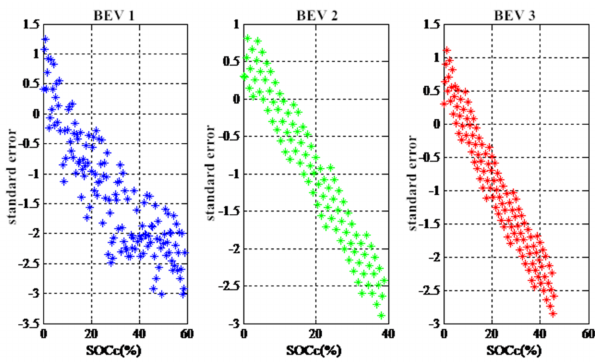
Figure 3. Standard error of charging time prediction.